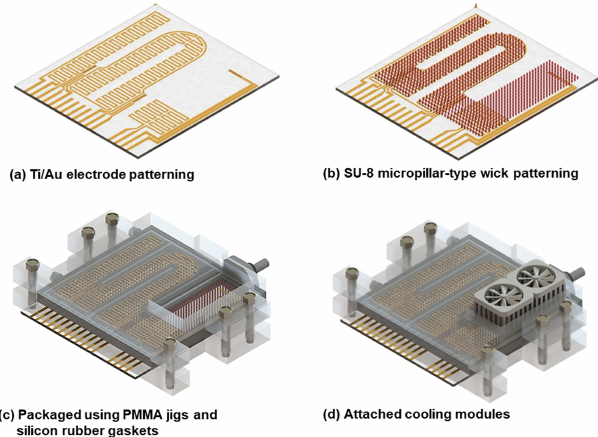
Figure 3. Simplified fabrication process of the MEMS-based